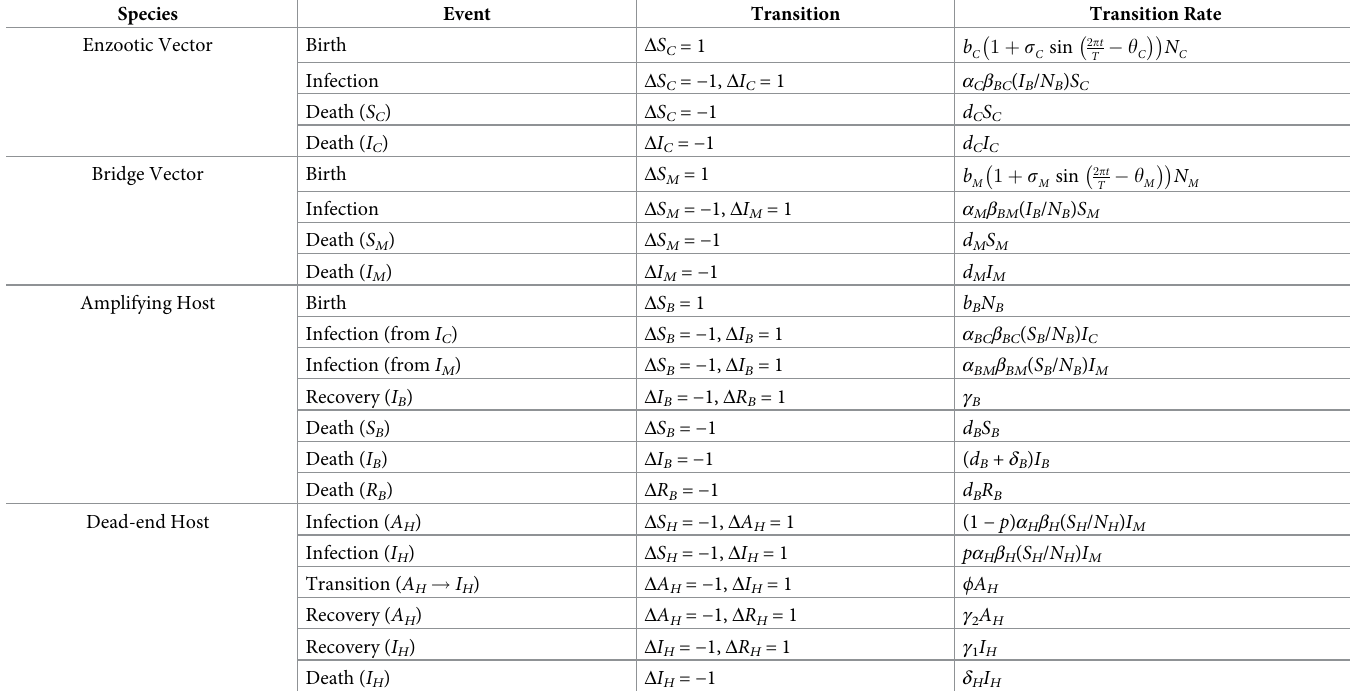
Table 1. CTMC transition table. CTMC model transitions between states and rates. For each time interval, the number of each event that occurs is sampled from a Pois- son distribution with the mean of τ times the corresponding transition rate in the table. When a single event occurs, each compartment’s population changes as described in the ‘Transition’